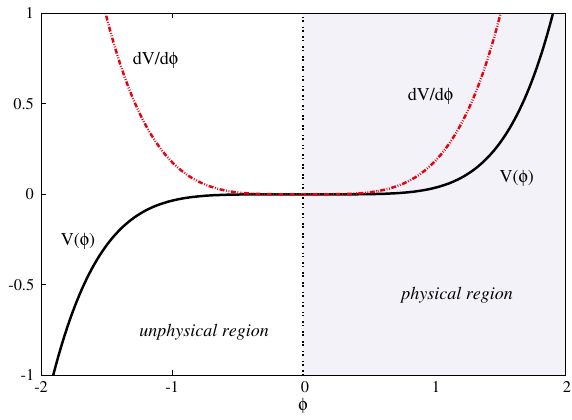
Figure 1 . The potential of the model, eq.